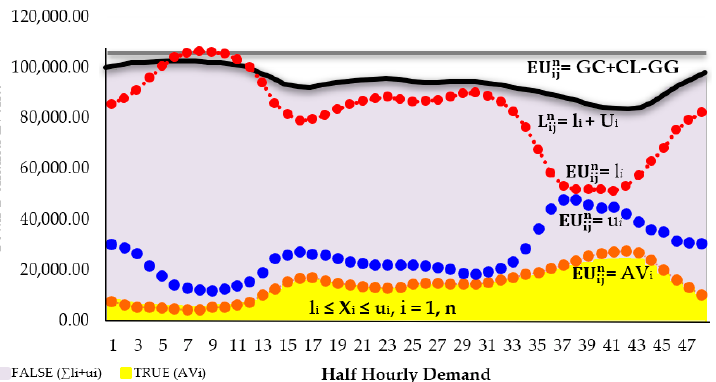
Figure 12. Average and No Average Events by End-Users.